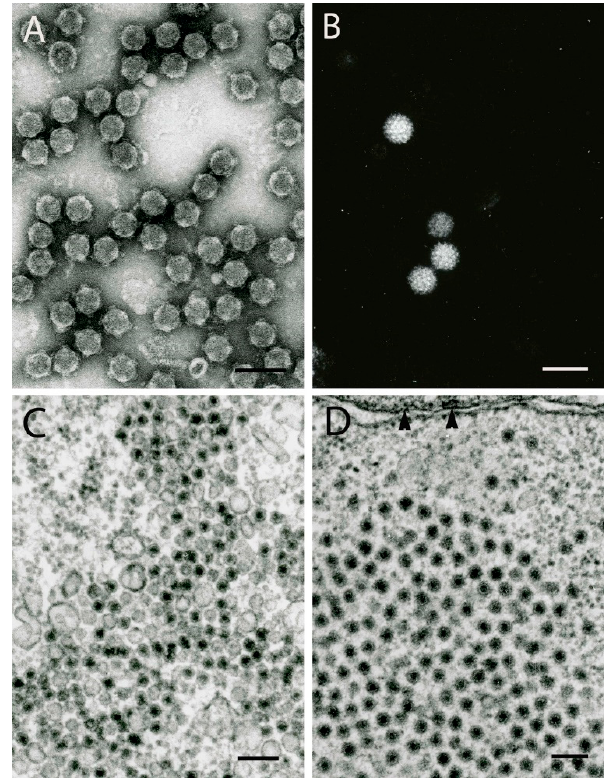
Figure 6. Ultrastructure of viruses of the family Reoviridae . ( A ) Negative staining of purified Fako virus (strain CSW77; unassigned probable genus Dinovernavirus , subfamily Spinareovirinae ). Virions 55–60 nm in diameter, each virion image has 5–6 turreted spikes, ~7 nm tall and ~15 nm wide. ( B ) Negative staining of purified Kadipiro virus (strain JKT-7075), genus Seadornavirus , subfamily Sedoreovirinae . Virions 55–65 nm in diameter, surface subunits ~7 nm in diameter. ( C ) Accumulation of virions of Fako virus (~45 nm in diameter) in an infected C6/36 cell. ( D ) Virions (~45 nm in diameter) of Banna virus (strain JKT-6423), genus Seadornavirus , subfamily Sedoreovirinae , in the cytoplasm of an infected C6/36 cell. Arrowheads indicate a fragment of the cell nucleus. Bars = 100 nm. Viruses 2019 , 11 , x FOR PEER REVIEW